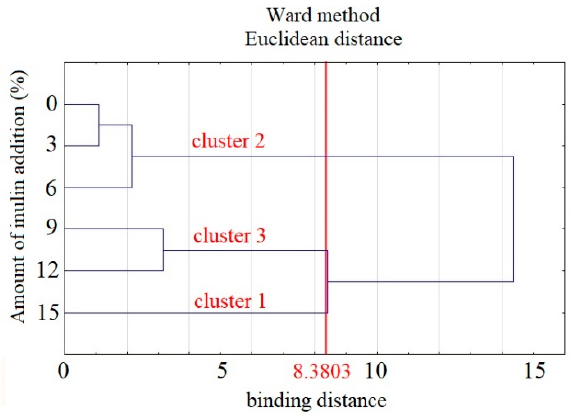
Figure 11. Tree diagram as a result of cluster analysis using the Ward method.